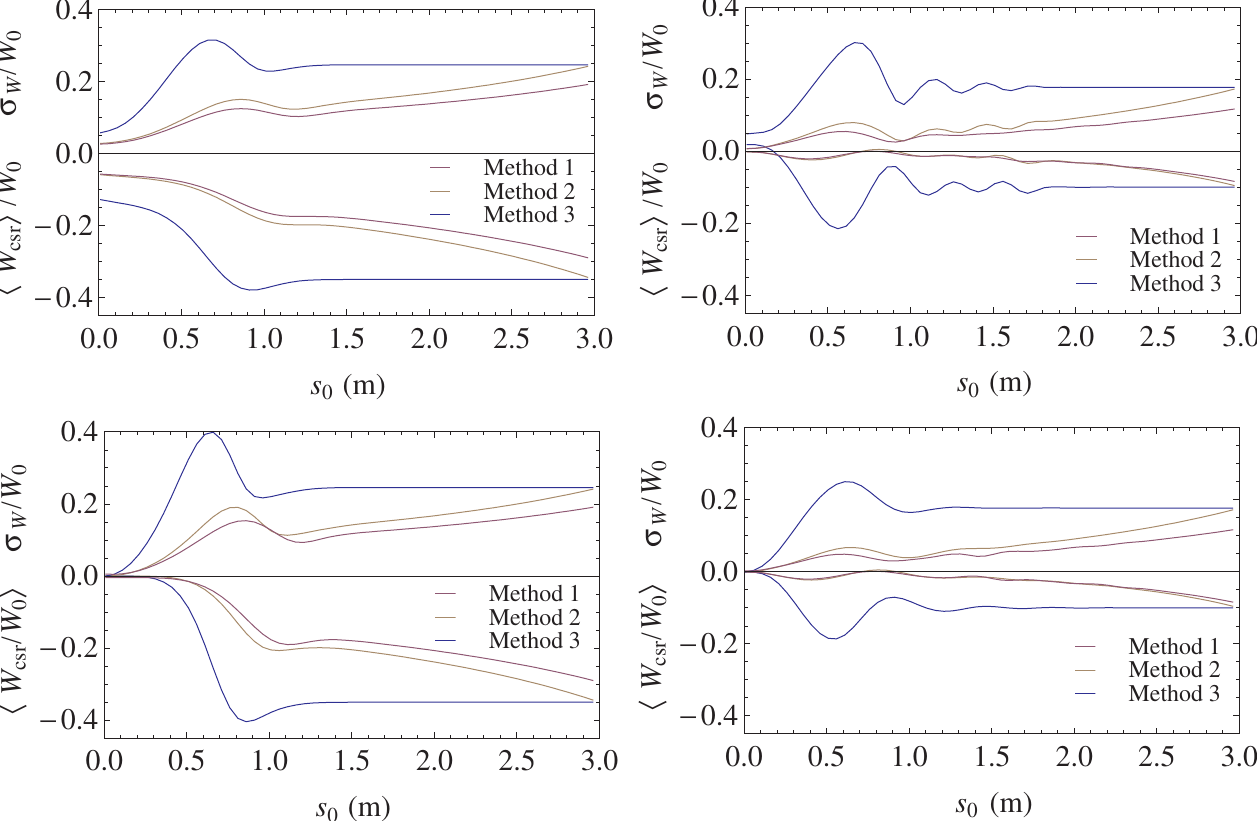
FIG. 15. (Color) The average and standard deviation of the CSR wake in free space (a) and between parallel plates with H ¼ 2 cm (b) over a Gaussian bunch, compressing from (cid:10) ¼ 0 : 9 mm to (cid:10) ¼ 0 : 6 mm linearly through bend 2, and from (cid:10) ¼ 0 : 6 mm to (cid:10) ¼ ¼ 1 m , while parts (c) and (d) have 0 : 3 mm linearly through bend 1, using methods described in the text. Parts (a) and (b) have D 1 D ! 1 . The lengths B ¼ B ¼ 3 m , the bending radii are (cid:7) (cid:1) 1 ¼ (cid:7) (cid:1) 1 ¼ 10 m , and the energy is 1 1 1 2 1 2